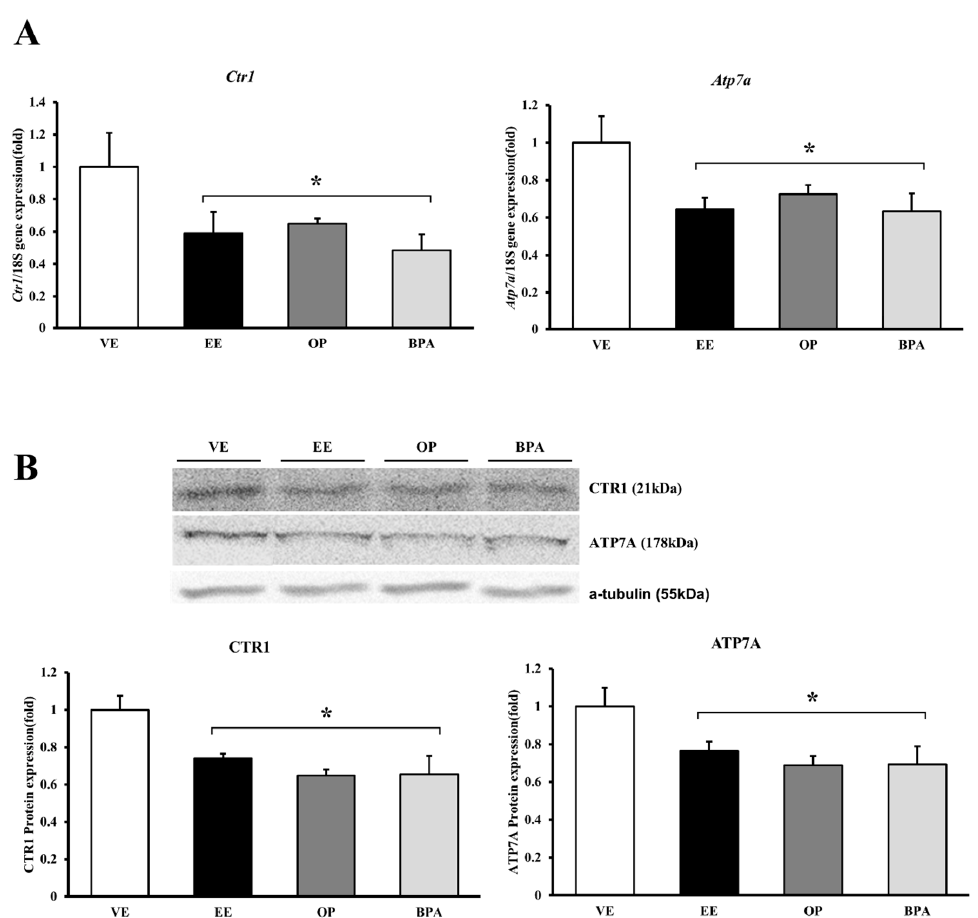
Figure 2. mRNA and protein expression of copper transporter channel in mouse placenta. The expression of calcium-transporting channel gene was examined by real-time PCR, and normalized by Rn18S . Protein expression was examined by Western blotting. mRNA expression of Ctr1 and Atp7a ( A ); protein expression of CTR1 and ATP7A ( B ). * p < 0.05 vs. VE. Data are presented as the mean ± SD. VE DMSO 5%, EE 0.2 mg/kg, OP, BPA 50 mg/kg.